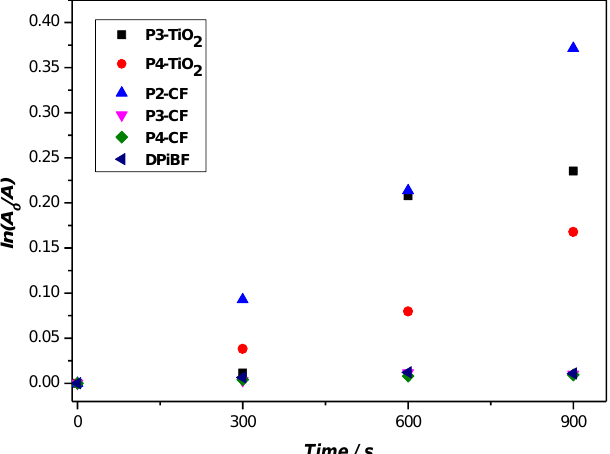
Figure 8. Time-dependent photodecomposition of DPiBF (50 µ M) photosensitized by P2-CF , P3-CF , P4-CF , P3-TiO 2 and P4-TiO 2 in DMF upon irradiation with red light (640 ± 20 nm) using 2.0 µ M of PS.